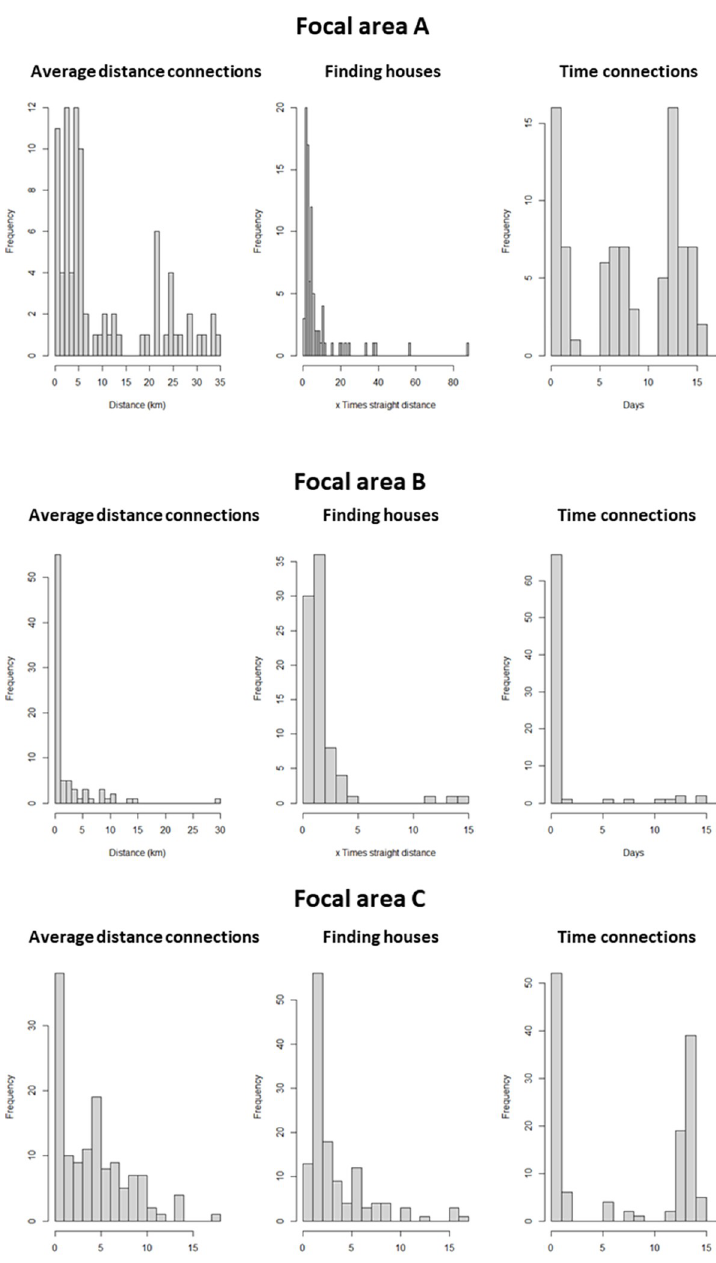
Fig 4. MALSWOTS time and distance analyses between house connections within each focal area. The ‘average distance connections’ refers to successful connections only. The ‘finding houses’ measure (central histogram) is the ratio between the length of the connection between two houses in which a mosquito has flown and the straight line (Euclidean) distance between the same houses (which can be shorter than the connection distance due to the zig-zag movement of the mosquito). The ‘time connections’ shows the temporal distance between infecting and infected houses in terms of RDT positive test. This time can be shorter than the days of flight (Table 2) due to the possibility that the mosquito left the infecting house prior malaria detection in the